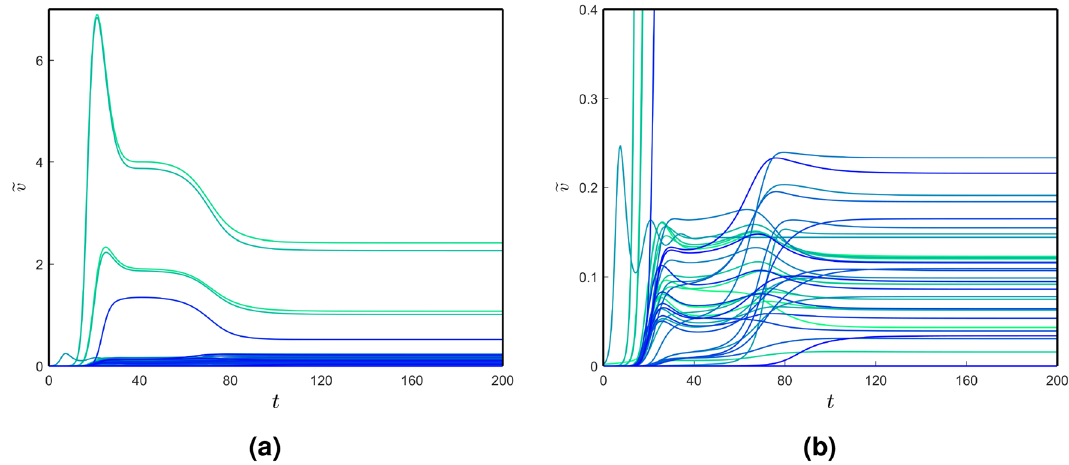
Figure 8. (Color online) Node-wise toxic- τ P distributions over time for the nonlocal model ( η = 0.5 ) with mixed tauopathy: ( a ) different curves corresponding to different brain regions; ( b ) zoom version of ( a ).